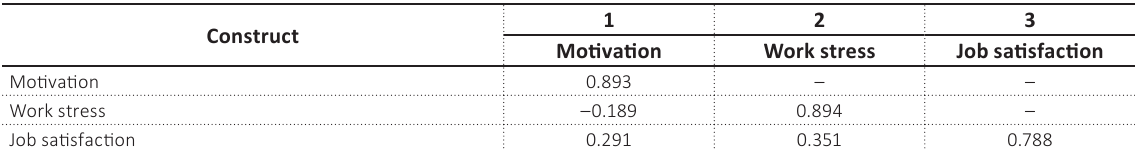
Table 4. Test of discriminant validity – Fornell-Larcke’s